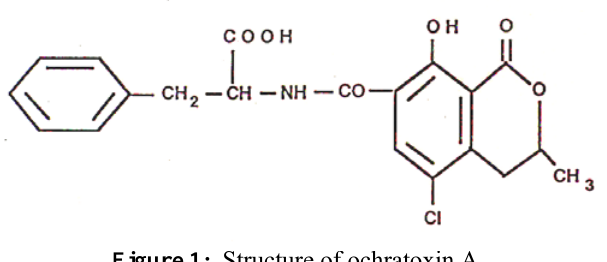
Figure 1: Structure of ochratoxin A Exposure to OTA has been linked with BEN, a chronic kidney disease associated with urothelial tumours, [2, 4, 20]. In Tunisia, a Chronic Interstitial Nephropathy (CIN) of unknown aetiology bearing striking similarities with BEN in its pathogenic characteristics was under investigation for more than one decade for implication of OTA [2, 7, 21]. Taking into account the high prevalence of ochratoxin A in blood of Tunisian people and the above quoted disease as compared to other kidney diseases and, considering that healthy populations are equally exposed, links were established that tend to demonstrate the causative role of OTA in ill persons [5, 7,